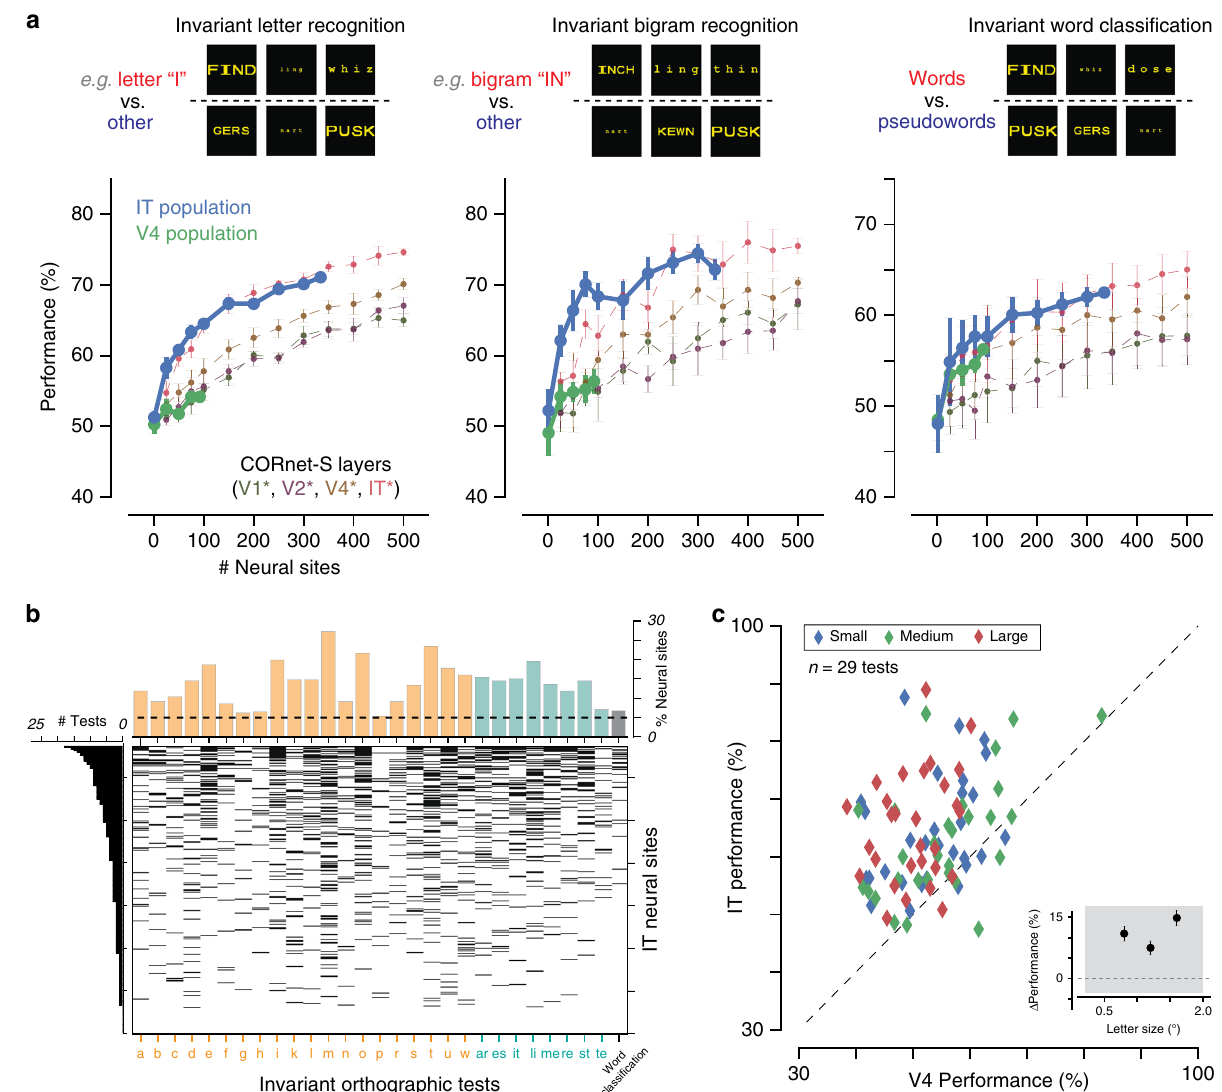
Fig. 3 Performance of IT population on a battery of orthographic processing tasks. a Performance of linear decoders trained on the IT and V4 representations on invariant orthographic tests, grouped into letter identi fi cation ( n = 20 tests), bigram identi fi cation ( n = 8 tests) and invariant word classi fi cation. Performance of arti fi cial representations sampled from layers of deep convolutional neural network model CORnet-S are shown in grey. Error bars correspond to SD across feature samples (neural sites or CORnet-S features). b Selectivity of individual IT sites over 29 invariant orthographic processing tests. The heatmap shows selectivity signi fi cantly different from zero overall pairs of neural sites and tests. The histogram above shows the number of behavioral tests (N t ) that each neural site exhibited selectivity for; neural sites are ordered by increasing N t . The histogram on the right shows the proportion of neural sites exhibiting selectivity for each test; the behavioral tests are ordered alphabetically within each task group (letter identi fi cation in orange, bigram identi fi cation in cyan, and word classi fi cation in gray). Dashed line corresponds to proportion of tests expected from chance (alpha = 5%). c Comparison of V4 and IT linear decoder performance across all 29 invariant orthographic tests from a and b , separated by letter size (small, medium, large). Inset shows the average difference in performance between IT and V4 (mean ± SE, n = 29 tests; positive values corresponding to IT > V4), for each letter size. The shaded region corresponds to the “ normal ” range of letter sizes, over which humans exhibit substantial tolerance. IT linear decodes consistently outperform V4 across this range of stimulus sizes, suggesting that the observed differences between IT and V4 are not simply a consequence of stimulus tested the CORnet-S model 29 , as it is currently the best match to CORnet-S (simulated IT) signi fi cantly outperforms earlier layers the primate ventral visual stream 30,31 and provides an indepen- (simulated upstream areas V1, V2, and V4) on these invariant dently simulated estimate of the neuronal population responses orthographic discrimination tasks, and tightly matches the from each retinotopically de fi ned cortical area in the ventral performance of the actual IT population. visual hierarchy (V1, V2, V4, and IT). Figure 3 shows the performance of decoders trained on each simulated neuronal population on invariant letter identi fi cation, invariant bigram identi fi cation, and invariant word classi fi cation, as a function of the number of model units used for decoding. The last layer of